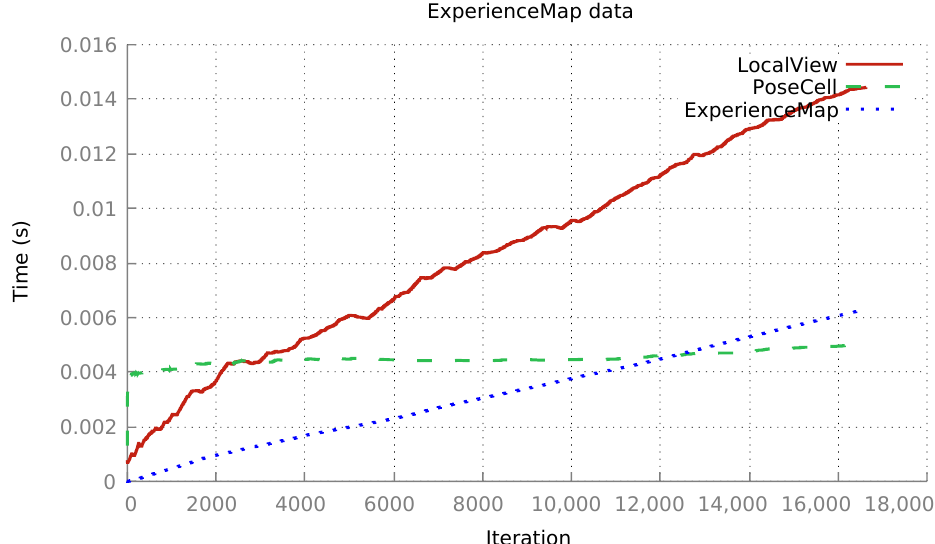
Figure 7. The iRat experiment analysed by xRatSLAM. Modules execution time over iterations: LocalView average: 14.43 ms. PoseCell average: 4.99 ms. ExperienceMap average: 6.31 ms. Total time: 245